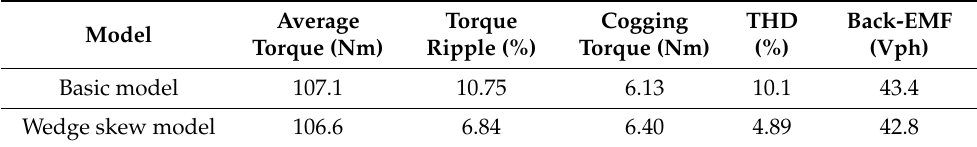
Figure 14. Comparison of magnetic density field distribution at 0 ms. ( a ) No wedge skew model; ( b ) wedge skew model. Table 4. Output characteristic of basic model and wedge skew model.